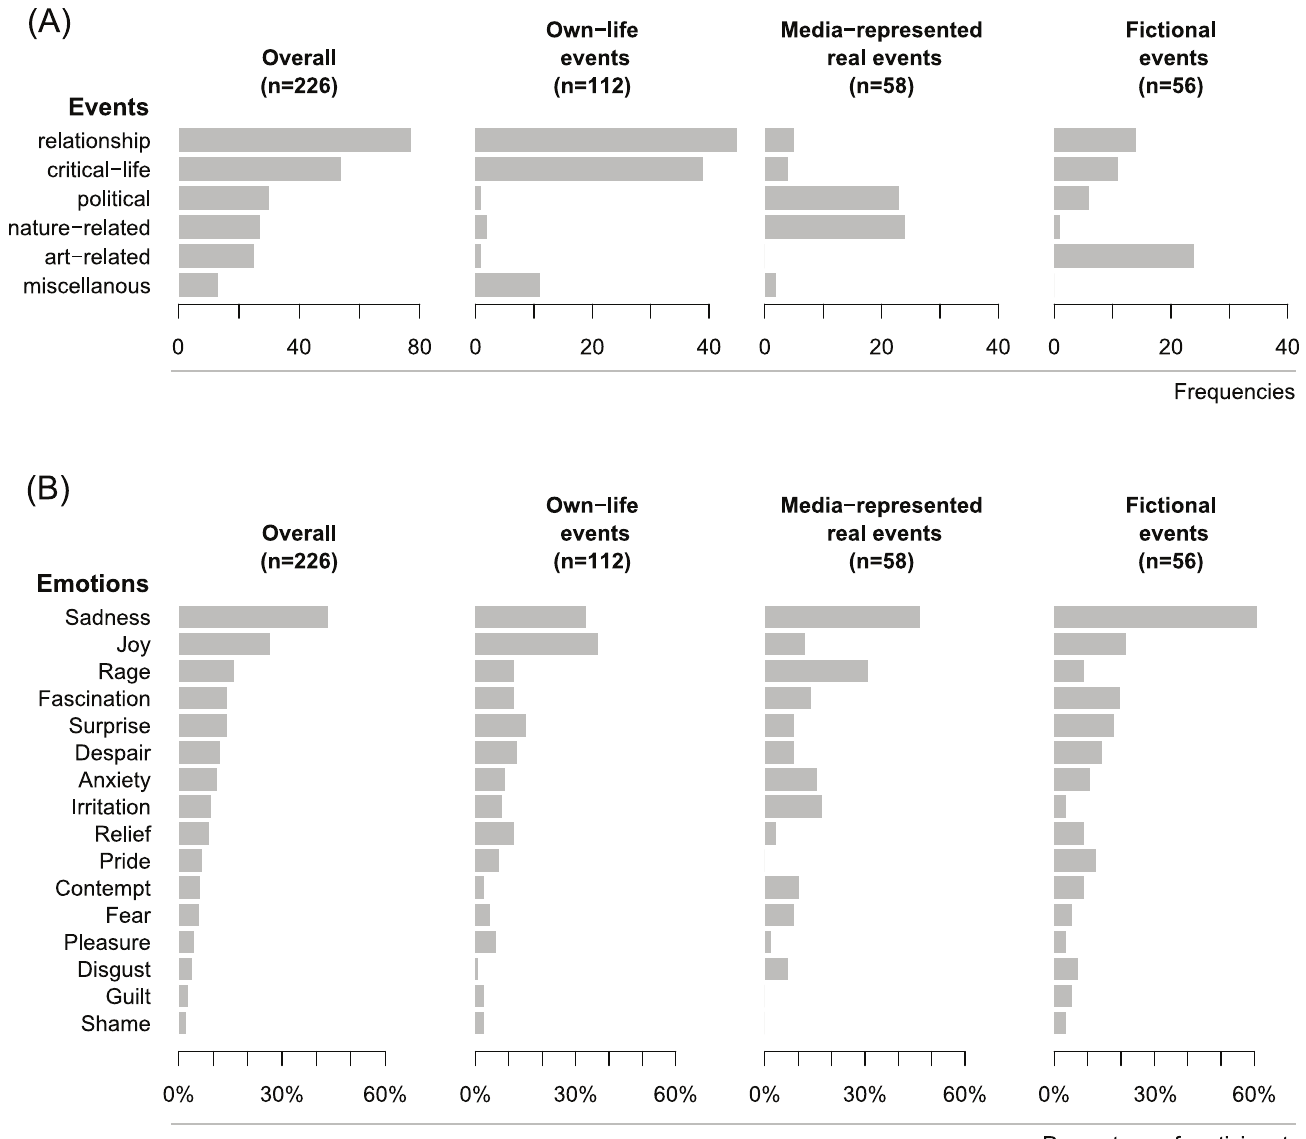
Fig 1. Eliciting events and emotional ingredients. (A) The frequencies of the six event types, overall and broken down by event group; (B) the emotions along with the percentage of participants who had experienced them, overall and broken down by event group. (Note that participants could mention several emotions; as a result, percentages do not add up to